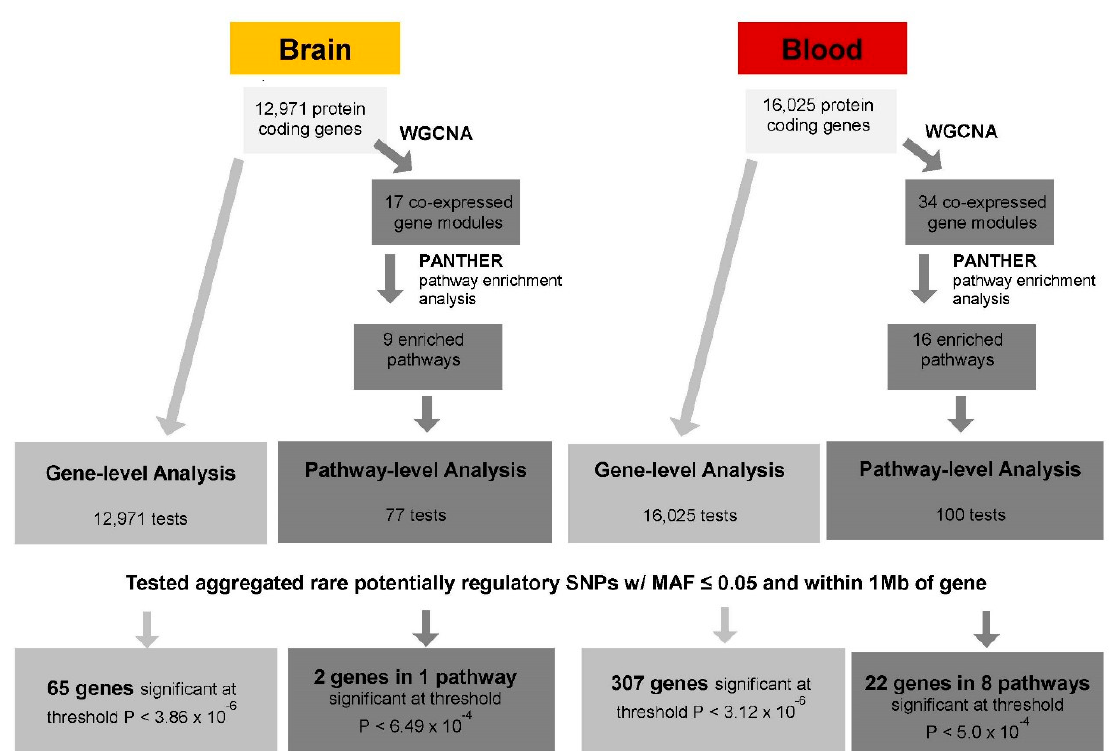
Figure 1. Overview of set-based rare expression quantitative trait loci (eQTL) analysis. Gene-level tests were performed for each protein-coding gene using an aggregate of all potentially regulatory single nucleotide polymorphisms (SNPs) with minor allele frequency ≤ 0.05 within 1 Mb of each gene. Pathway-level analysis was carried out in two steps. First, the weighted gene co-expression network analysis (WCGNA) method was applied to identify co-expressed gene modules. Next, pathway enrichment analysis was conducted using the Protein Analysis Through Evolutionary Relationships (PANTHER) tool to identify significantly enriched pathways in these gene modules, and pathway-level tests were then performed on each enriched pathway, including the aggregated SNPs for each gene in the module. Results were considered significant ( p < 0.05) after applying a Bonferroni correction.